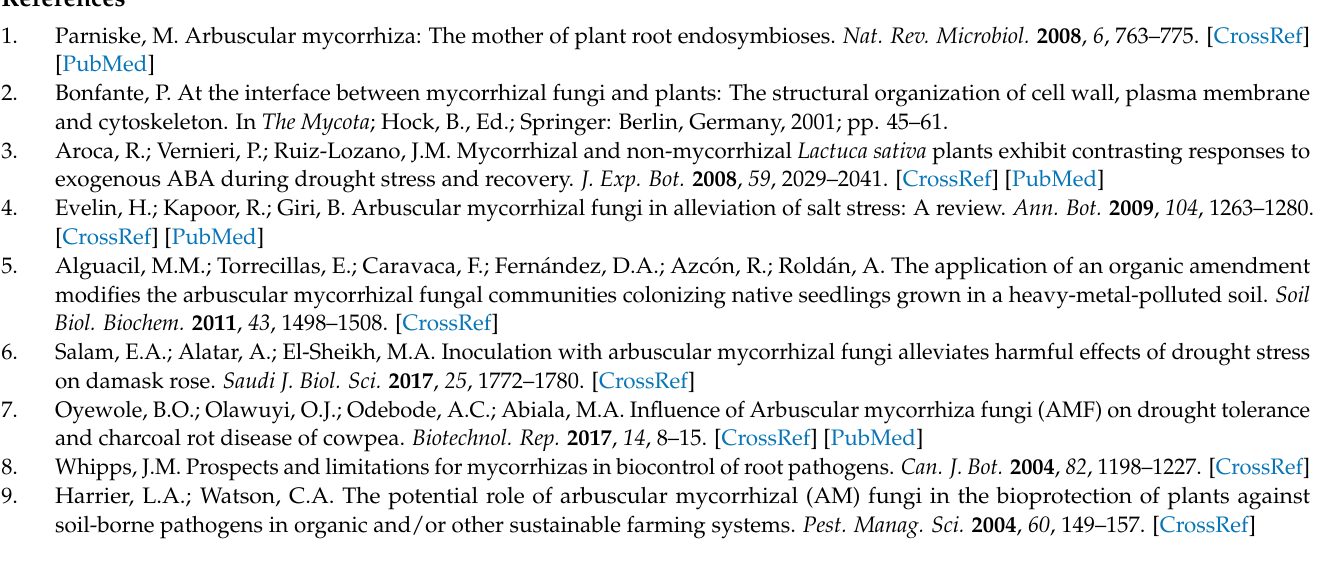
Figure A3. Normalized fold expression of cell wall-related genes in leaves of mycorrhizal tomato plants. Gene expression was determined by qRT-PCR (2 − ∆∆ Ct ). Values represent the average ± SE of the normalized relative expression (MYC/CTR) from three independent biological experiments (n = 3 per experiment). Ubiquitin was used as a reference gene for data normalization. (*) represent significantly different means between MYC/CTR according to the statistical analysis (Student ’ s t -test, p ≤ 0.05). Bars, ±SE.